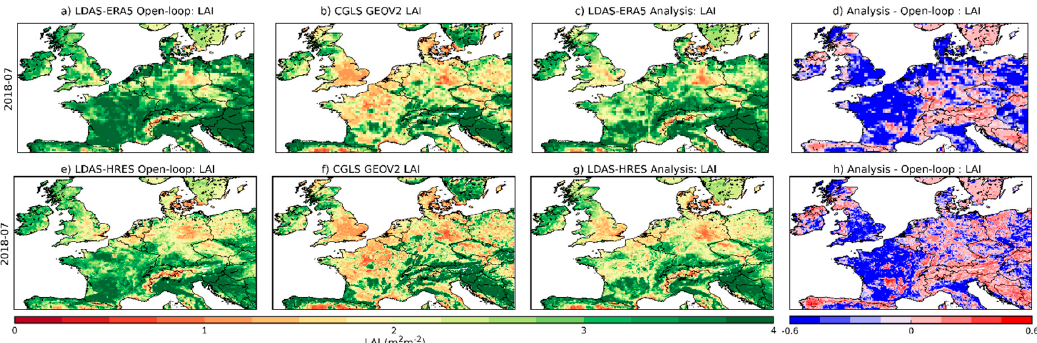
Figure 6. Upper panel, Leaf Area Index from ( a ) LDAS-ERA5 Open-loop, ( b ) the observations, ( c ) LDAS-ERA5 Analysis and ( d ) differences between LDAS-ERA5 Analysis and LDAS-ERA5 Open-loop for July 2018. Lower panel, ( e – h ) same as upper panel for LDAS-HRES. Spatial resolution of upper panel is 0.25° × 0.25°, spatial resolution of lower panel is 0.10° × 0.10°.